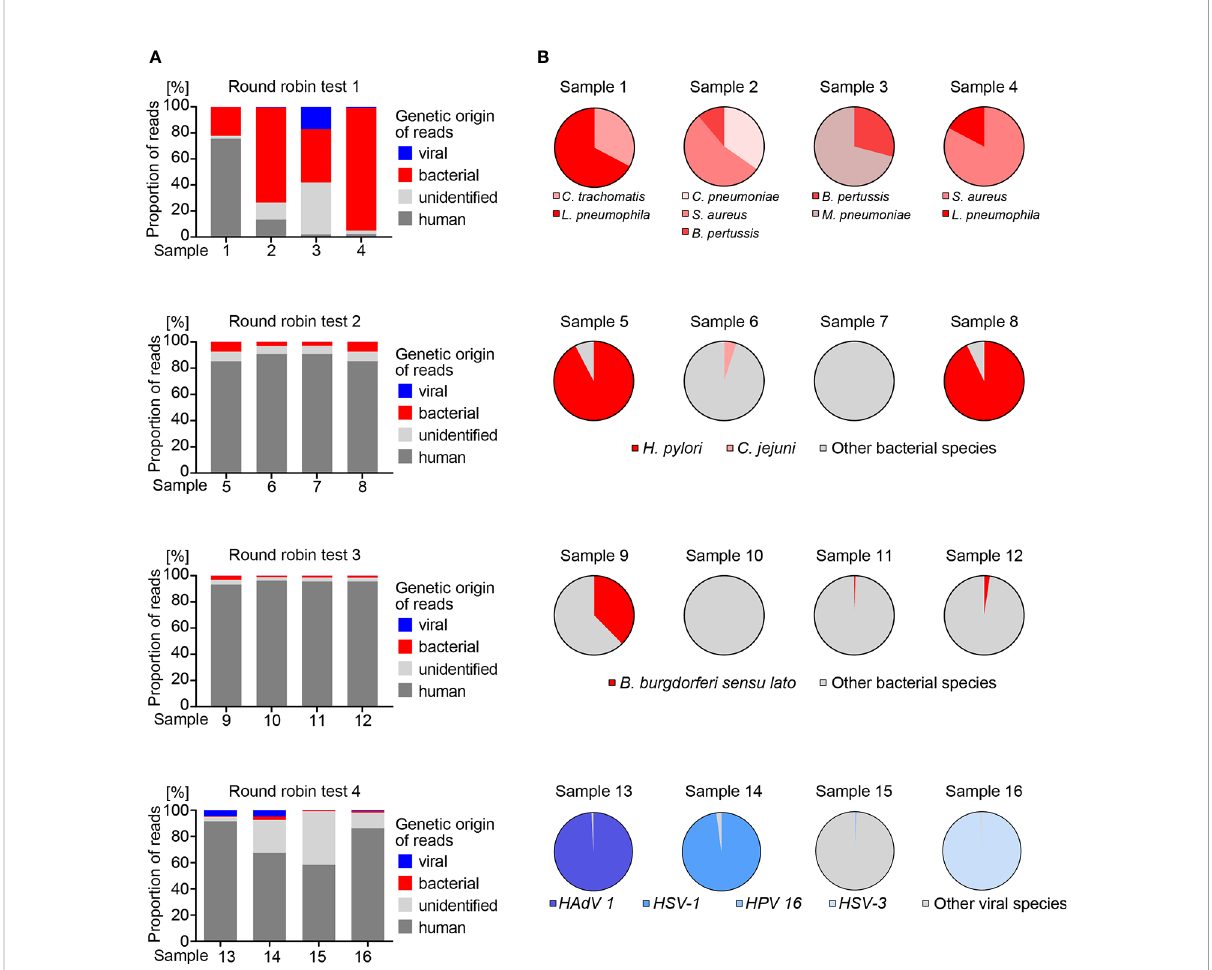
FIGURE 3 Bacterial and viral reference species identi fi ed by metagenomics analysis in round robin tests. (A) Genetic origin of sequence information interpreted from read mapping to the human genome GRCh37 (hg19) or taxonomic pro fi ling of non-human reads. Reads that could not be assigned to human, bacteria or viruses were labeled as unidenti fi ed. (B) Different species identi fi ed in bacterial and viral reads in individual round robin test